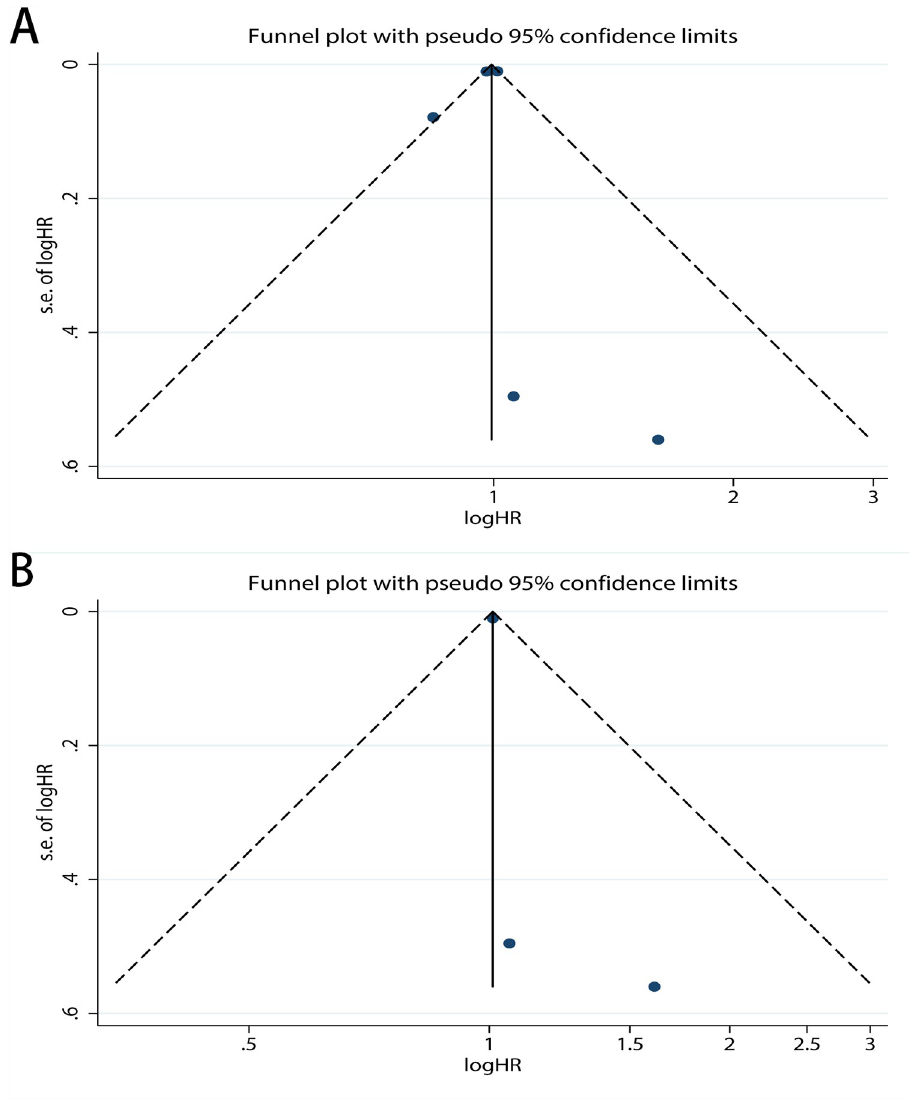
Fig 10. Funnel plot of CAIX expression and recurrence-free survival on A, all inclusion studies; B, by excluding the low quality score studies (quality score �